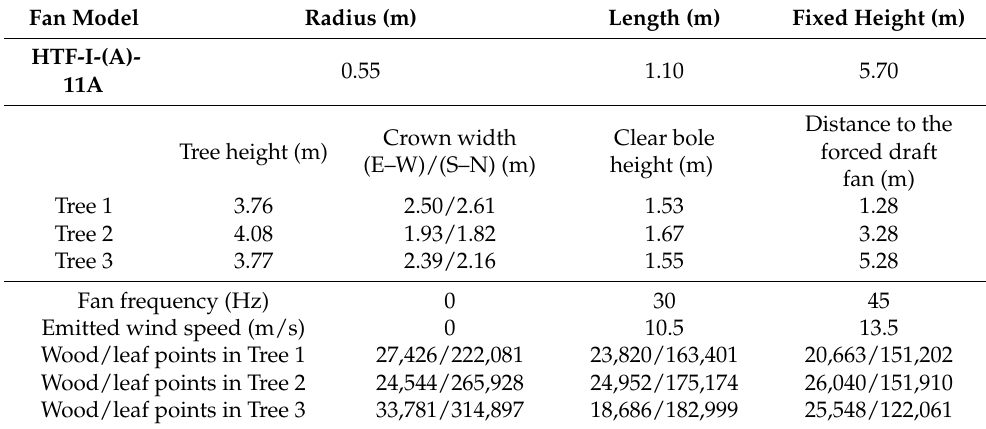
Figure 3. Photos showing the experimental site with three rubber trees arranged at a fixed in- terval in front of the forced draft fan. ( a – c ) show the real photos of the built steel lifting truss loading the fan and the experimental setup. Red circles in ( c ) indicate co-registration targets for the multi-scan co-registration. Table 2. Detailed technical specifications of the forced draft fan and wood and leaf points of the three experimental rubber